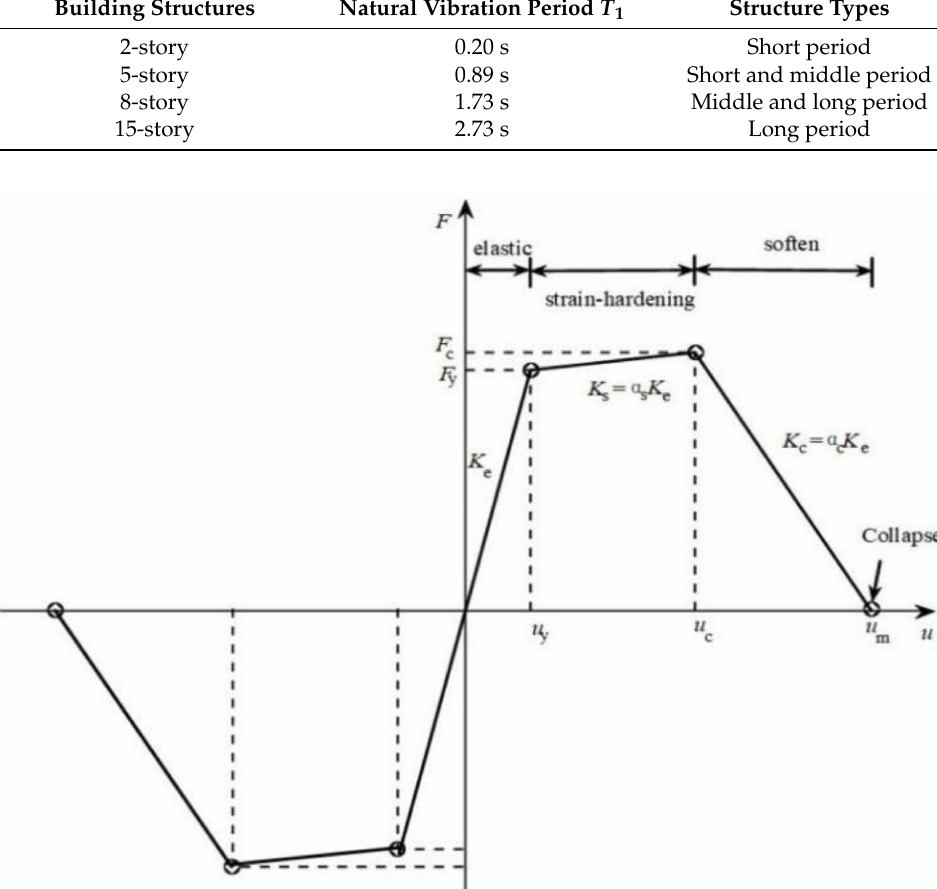
Figure 5. Backbone curve for improved I-K hysteretic model.